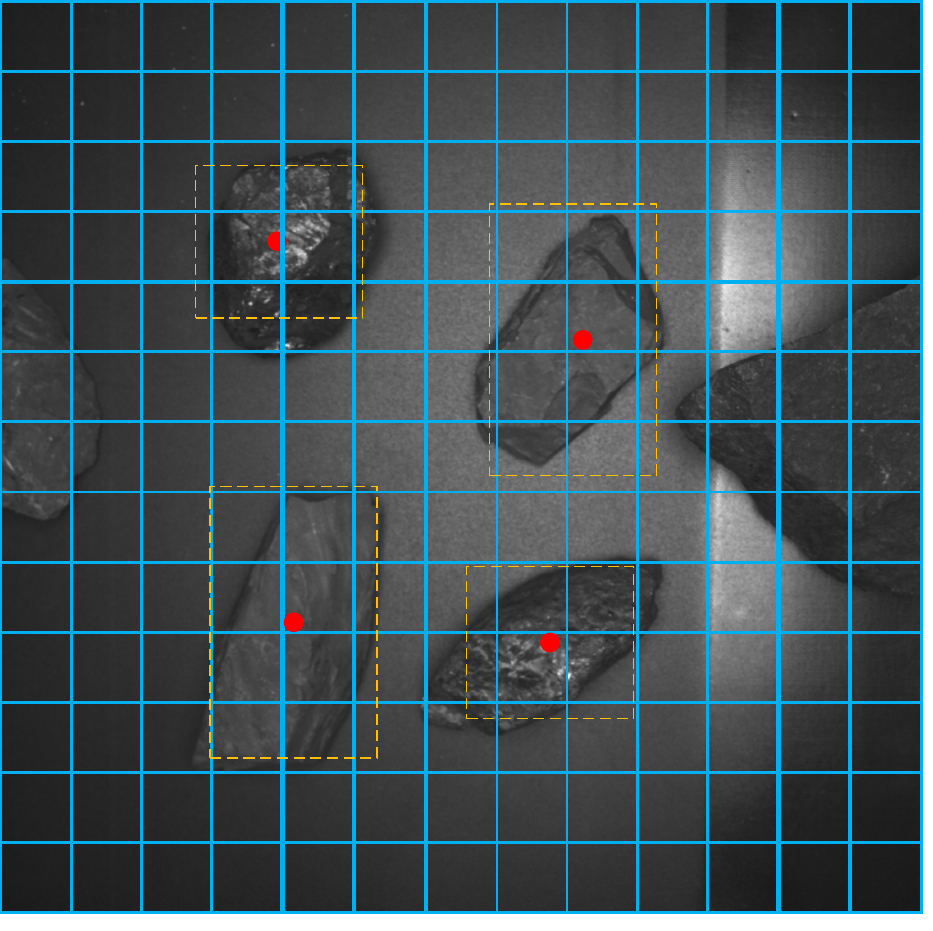
Figure 3. Matching and annotation of real frame.